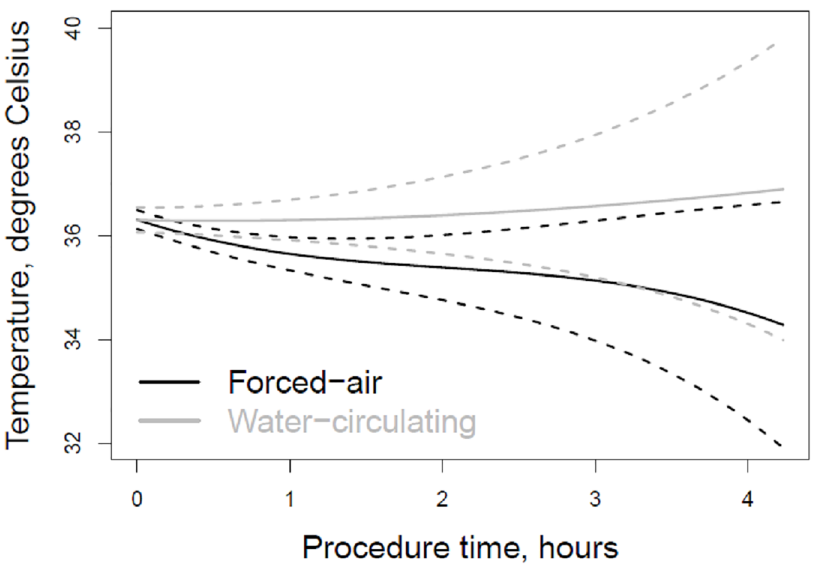
Fig 1. Mean temperature versus time in TAVR patients warmed with forced-air and water-circulating devices. Temperature decreasedsignificantly over time in the forced-airgroup (P < 0.001), and the trajectories for the two groups were significantly different (p = 0.004). Dashedlines represent95% confidence interval. Mean temperature over time was estimated with a random effect mixed model using B splines for time, and includedan interactionbetweentime and device status. The number of patients present at the 1, 2, 3, and 4-hour time points in the forced-air and water-circulating groups were 46 and 34, 43 and 19, 12 and 3, and 1 and 1, respectively.